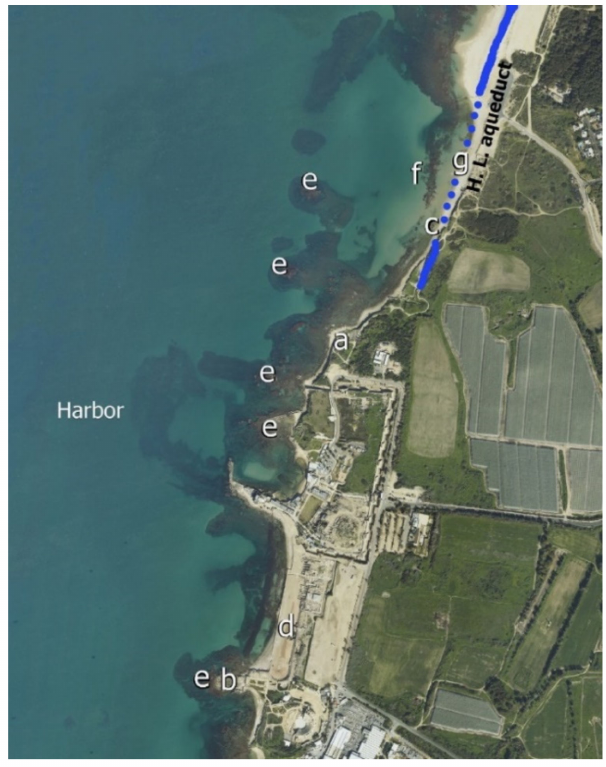
Figure 6. Aerial photo of the Caesarea coast: (a) the location of Straton Tower quay; (b) the rock-cut Roman palace pool; (c) the Byzantine sewer outlet; (d) the Roman circus and the location of the Late Roman-Byzantine urban-waste fill proposed by Goodman-Tchernov and Austin as a 6th and 8th century CE tsunami deposit [9]; (e) abrasion platforms; (f) beachrock ridge marking the Roman coastline; (g) the missing section of the